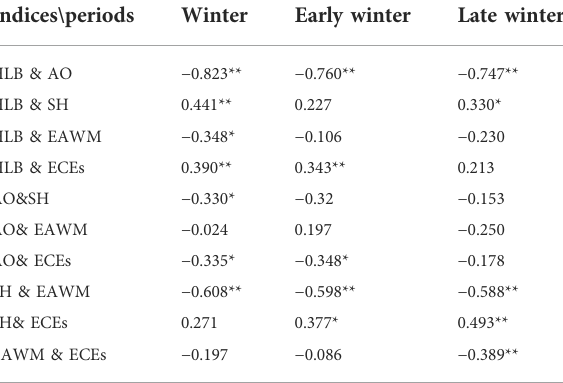
TABLE 1 Correlation coef fi cients between different indices in